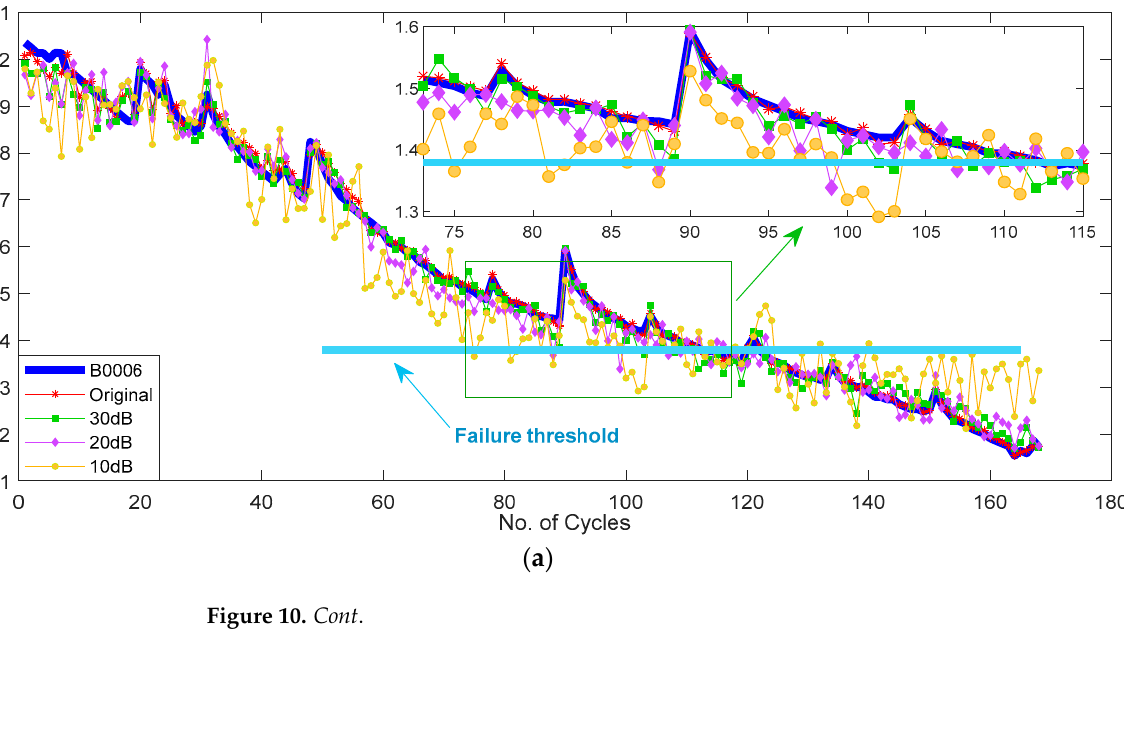
( b ) Figure 10. Prediction results of LAOS-XGboost model after adding noise. ( a ) SOH prediction re- sults of B0006 battery. ( b ) SOH prediction results of B0007 battery. The detailed indicators of the model are shown in Table 3. Table 3. Detailed prediction results of various models. Battery